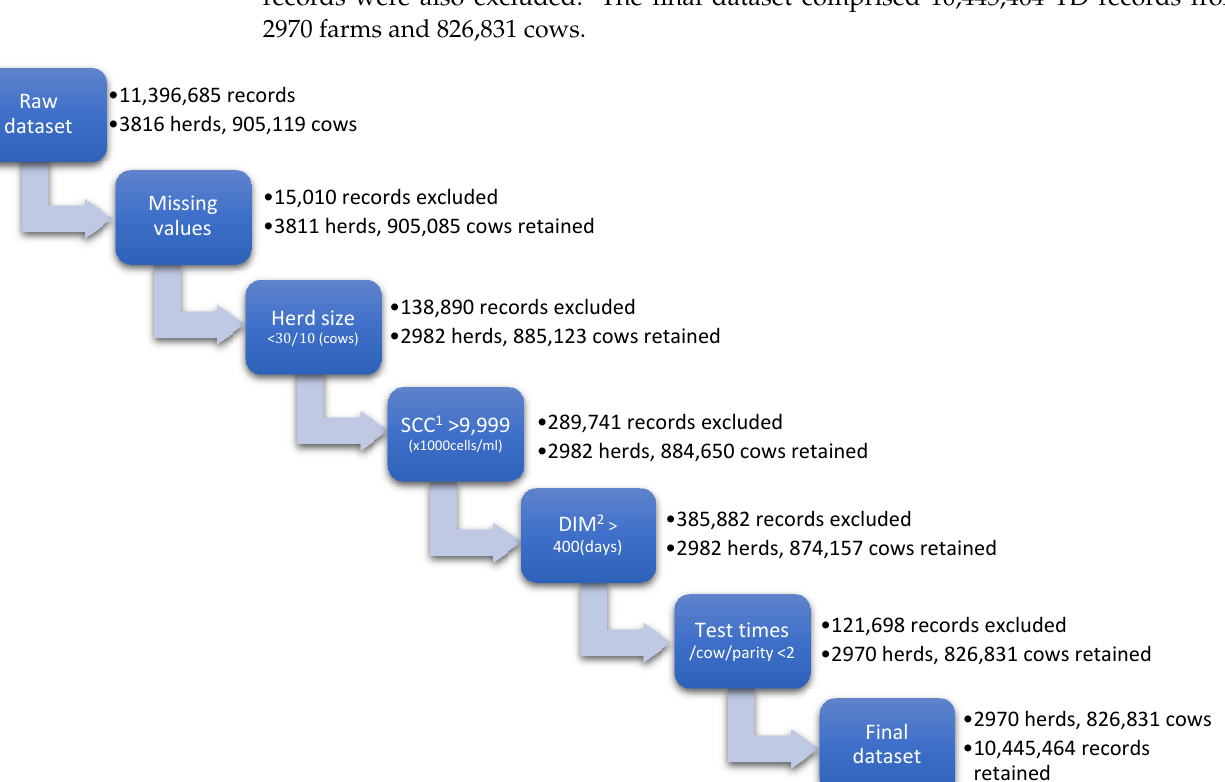
Figure 1. Editing criteria and number of herds, cows and test day records retained and excluded. 1 Somatic cell count. 2 Days in Milk.